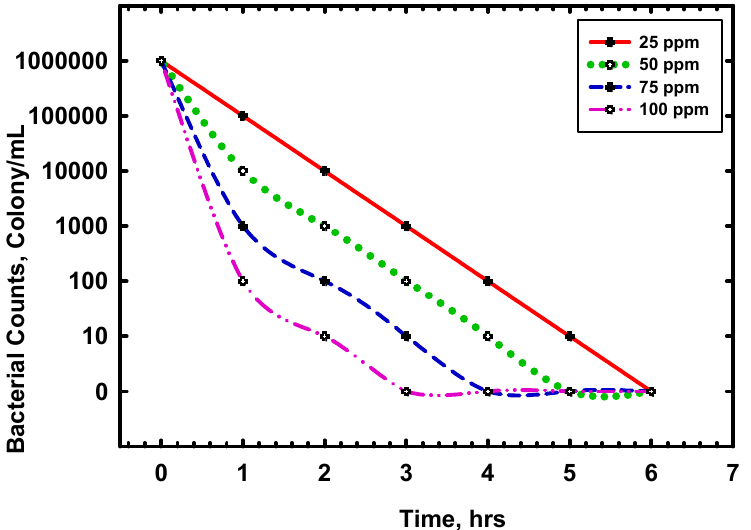
Figure 2. The decay of bacterial counts with time at different concentrations of the ionic liquid [OH-EMIm]Cl.